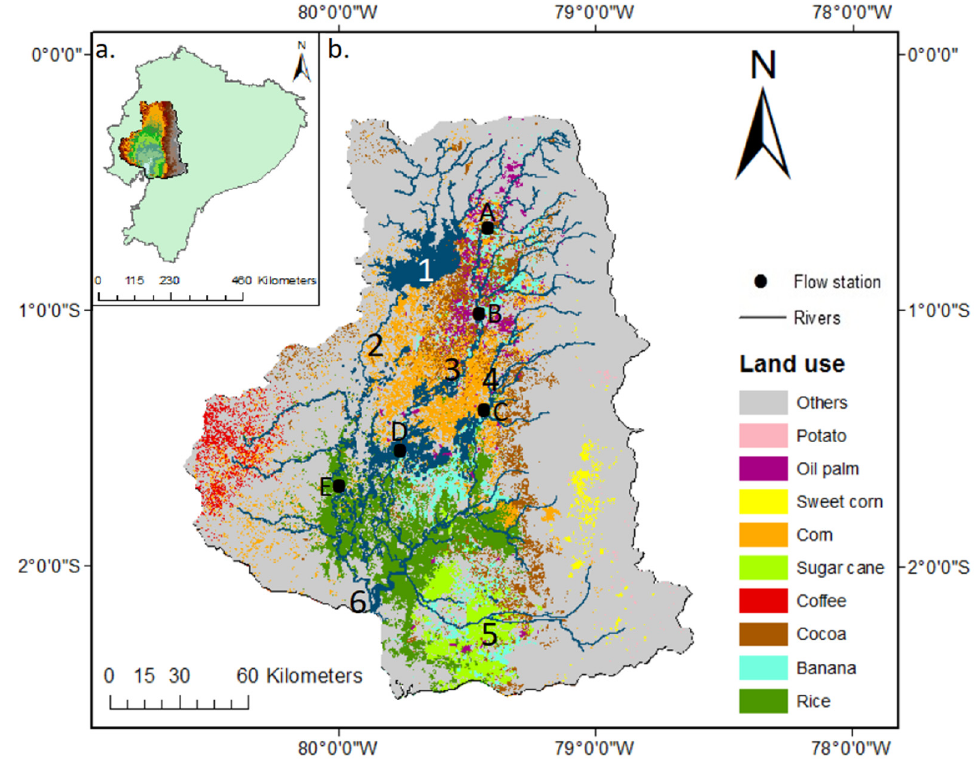
Figure 1. Location of the Guayas River basin in Ecuador ( a ). Land use, river network and streamflow stations ( b ). Numbers indicate the Daule Peripa Dam ( 1 ) and the main rivers, being Daule ( 2 ), Vinces ( 3 ), Babahoyo ( 4 ), Chimbo ( 5 ) and Guayas ( 6 ). Letters indicate the streamflow stations, being Baba dam ( A ), Quevedo en Quevedo ( B ), Zapotal en Lechugal ( C ), Vinces en Vinces ( D ) and Daule en La Capilla ( E ).